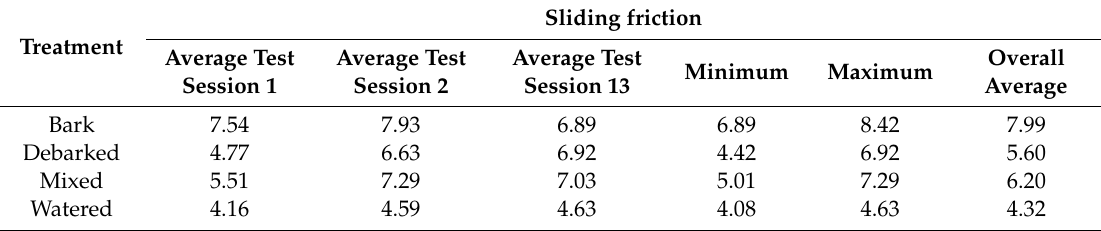
Figure 7. Correlation between pulling force (N) and mass of log (kg) for the first test session (day 1) for: ( A ) bark treatment, ( B ) debarked treatment, ( C ) mixed treatment, and ( D ) watered treatment. Correlation between pulling force and mass of log for the last test session (day 21) for ( E ) bark treatment, ( F ) debarked treatment, ( G ) mixed treatment, and ( H ) watered treatment. Table 2. Average sliding frictions in N Pull / kg Log of test sessions 1, 12, and 13 as well as minimum, maximum, and overall